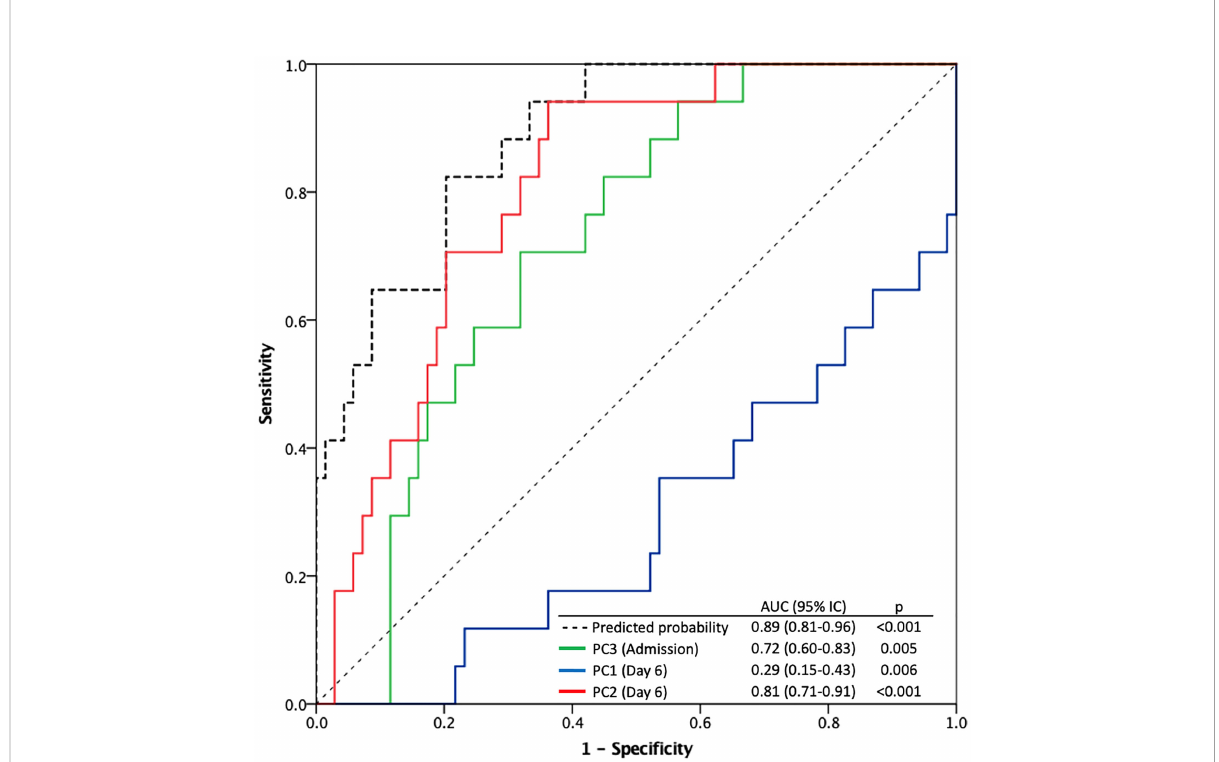
FIGURE 3 Receiver operating characteristic (ROC) curves for the predicted probability of the logistic regression model and signi fi cant predictors for 28- day mortality (PC3 at the day of admission, PC1 and PC2 at the sixth day after